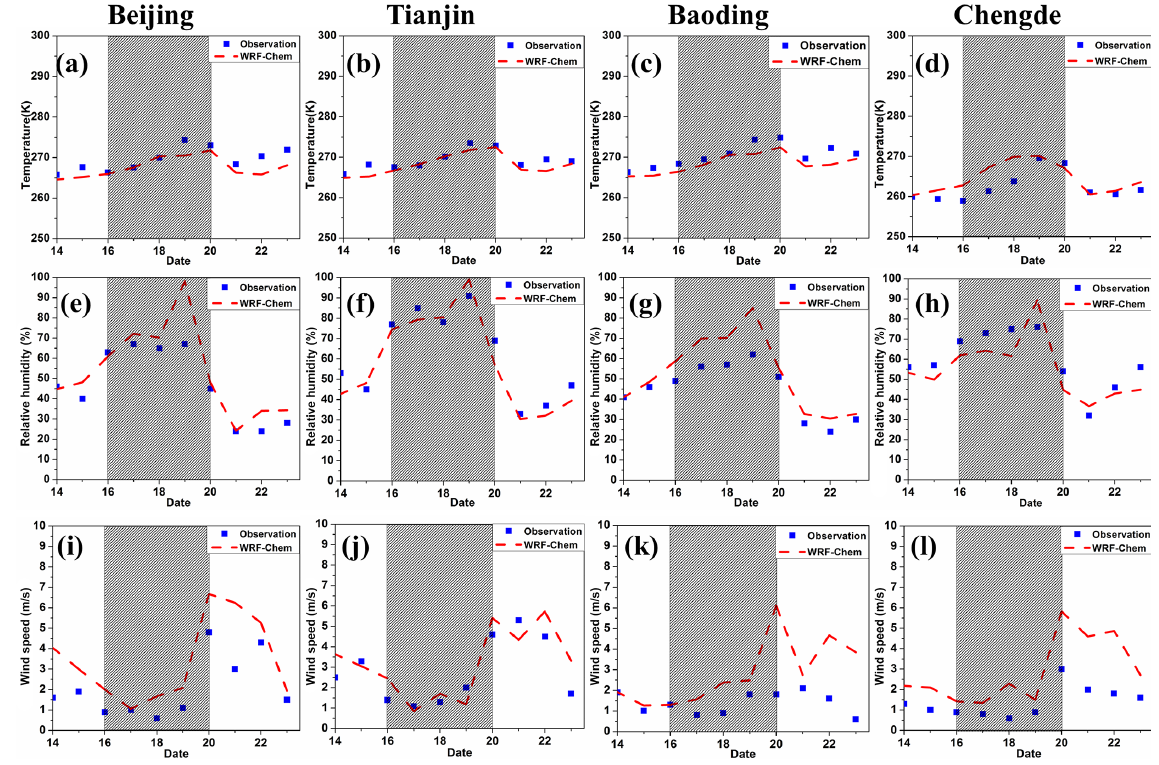
Figure 1. The temporal variations of observed and simulated 24h average temperature (a–d) , relative humidity (e–h) and wind speed (i–l) in the Beijing, Tianjin, Baoding, and Chengde